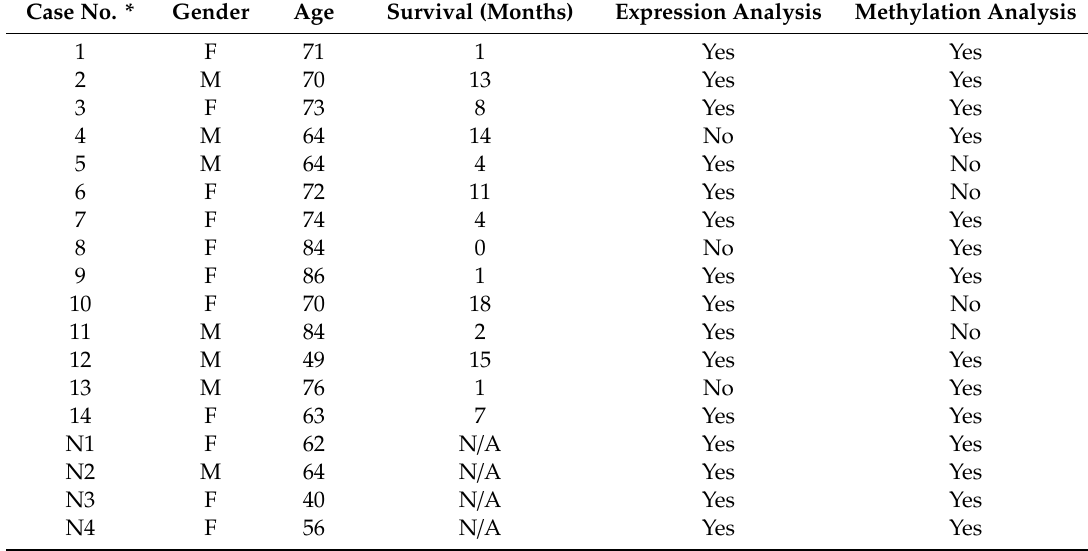
Table 1. Methylation and expression analysis of 14 cases of primary anaplastic thyroid cancer and tissue from 4 normal thyroids